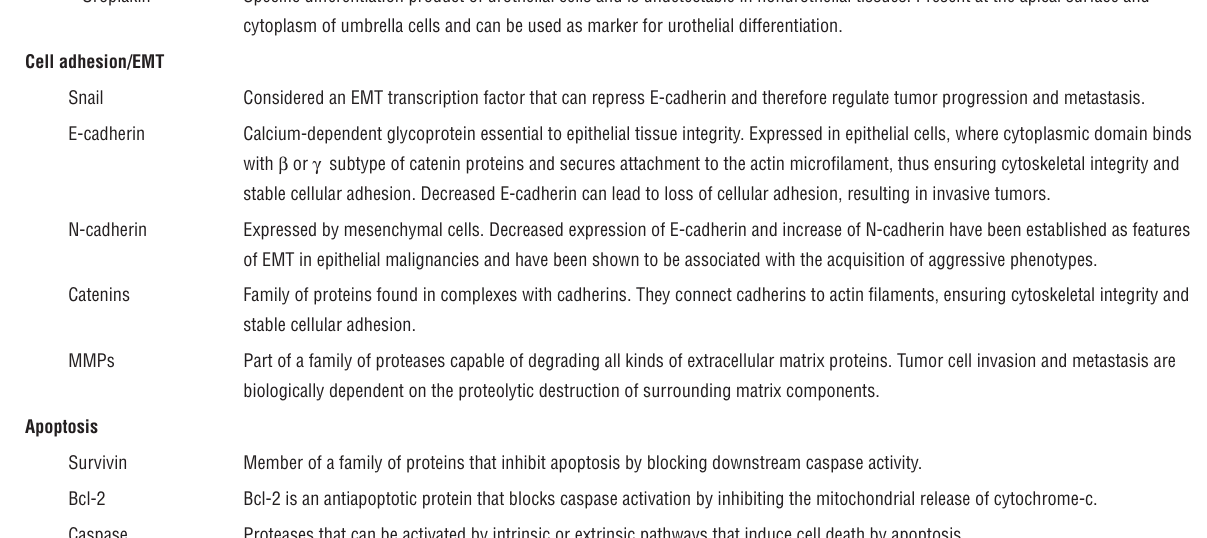
Table 1 – Tissue-based markers in upper tract urothelial carcinoma and their molecular functions. TISSUE-BASED MARKERS FUNCTION